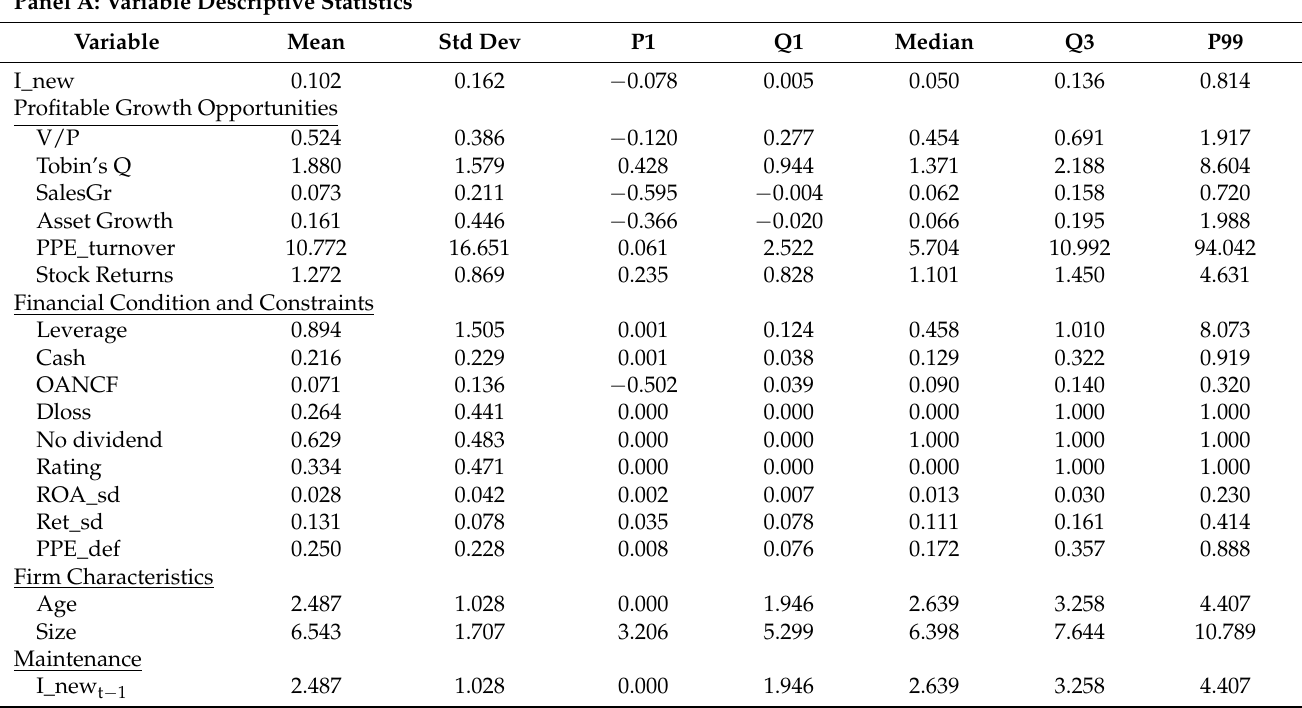
Table 3. CAPEX Investment